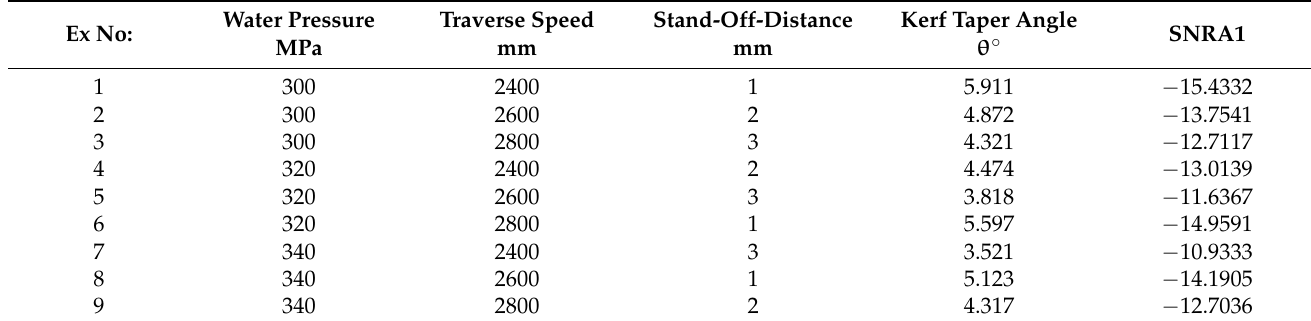
Table 16. L9 array of input parameter levels with measured Kerf taper angle θ ◦ in degrees and calculated signal-to-noise (S/N) ratio based on the Taguchi method for 2 mm specimen thickness cut with abrasive water jet technique.